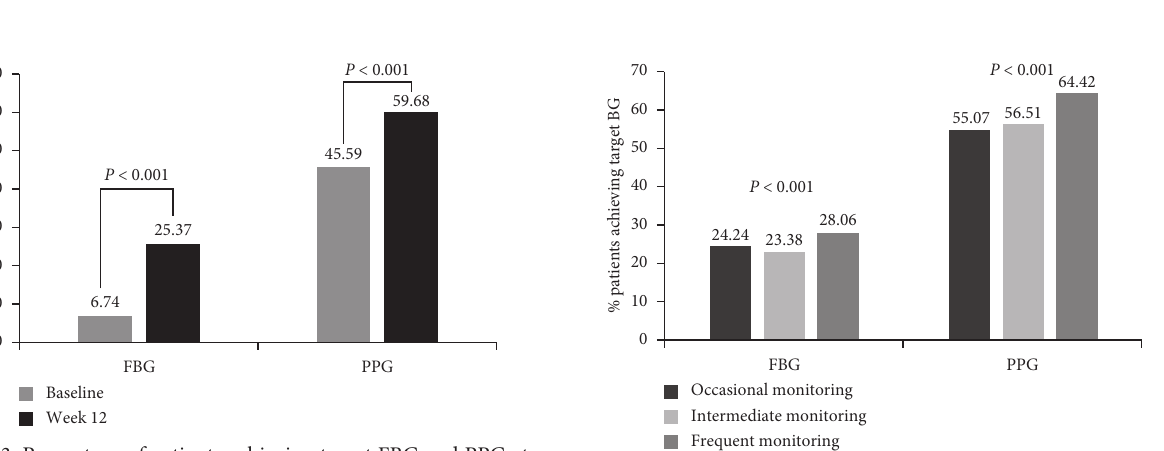
Figure 5: Percentage of patients achieving target FBG and PPG at week 12 with different frequency of monitoring. Occasional